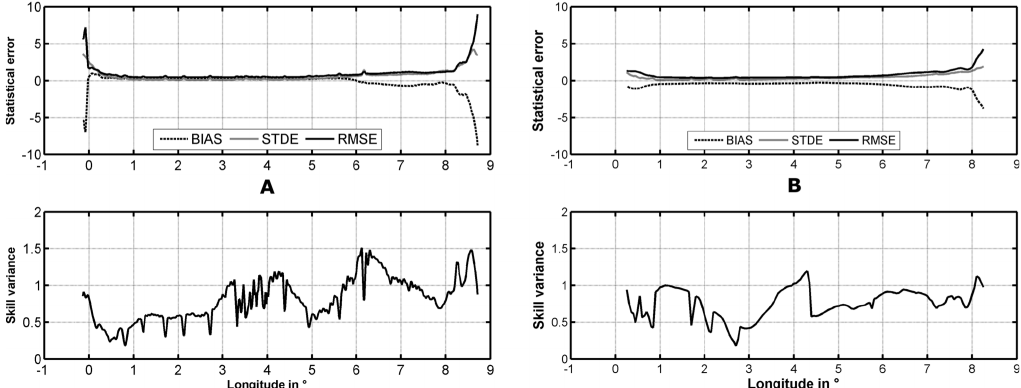
Figure 8. Standard deviation of error (stde), bias and RMSE (up) and skill variance (skvar) (down) of BSHcmod (a) and AMM7 (b) for salinity on the TorDania